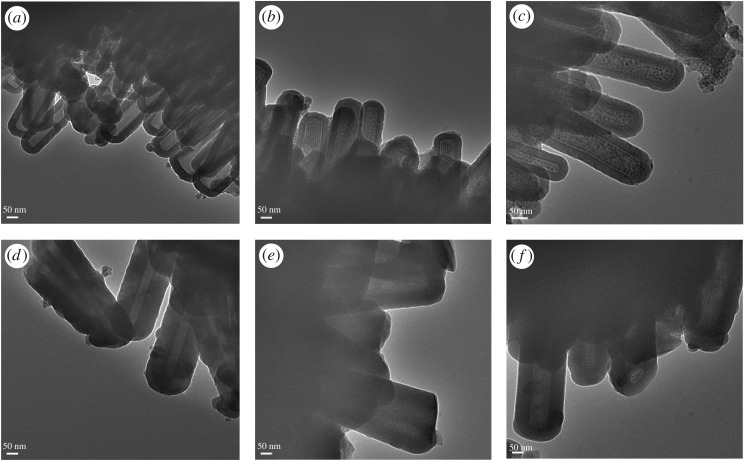
(a–c) TEM imaging of 40 nm Si NTs: (a) empty Si NTs; (b) Si NTs loaded with 5 nm Fe3O4; (c) Si NTs loaded with 8 nm Fe3O4. (d–f) TEM of 70 nm Si NTs: (d) empty Si NTs; (e) Si NTs loaded with 5 nm Fe3O4; (f) Si NTs loaded with 8 nm Fe3O4.